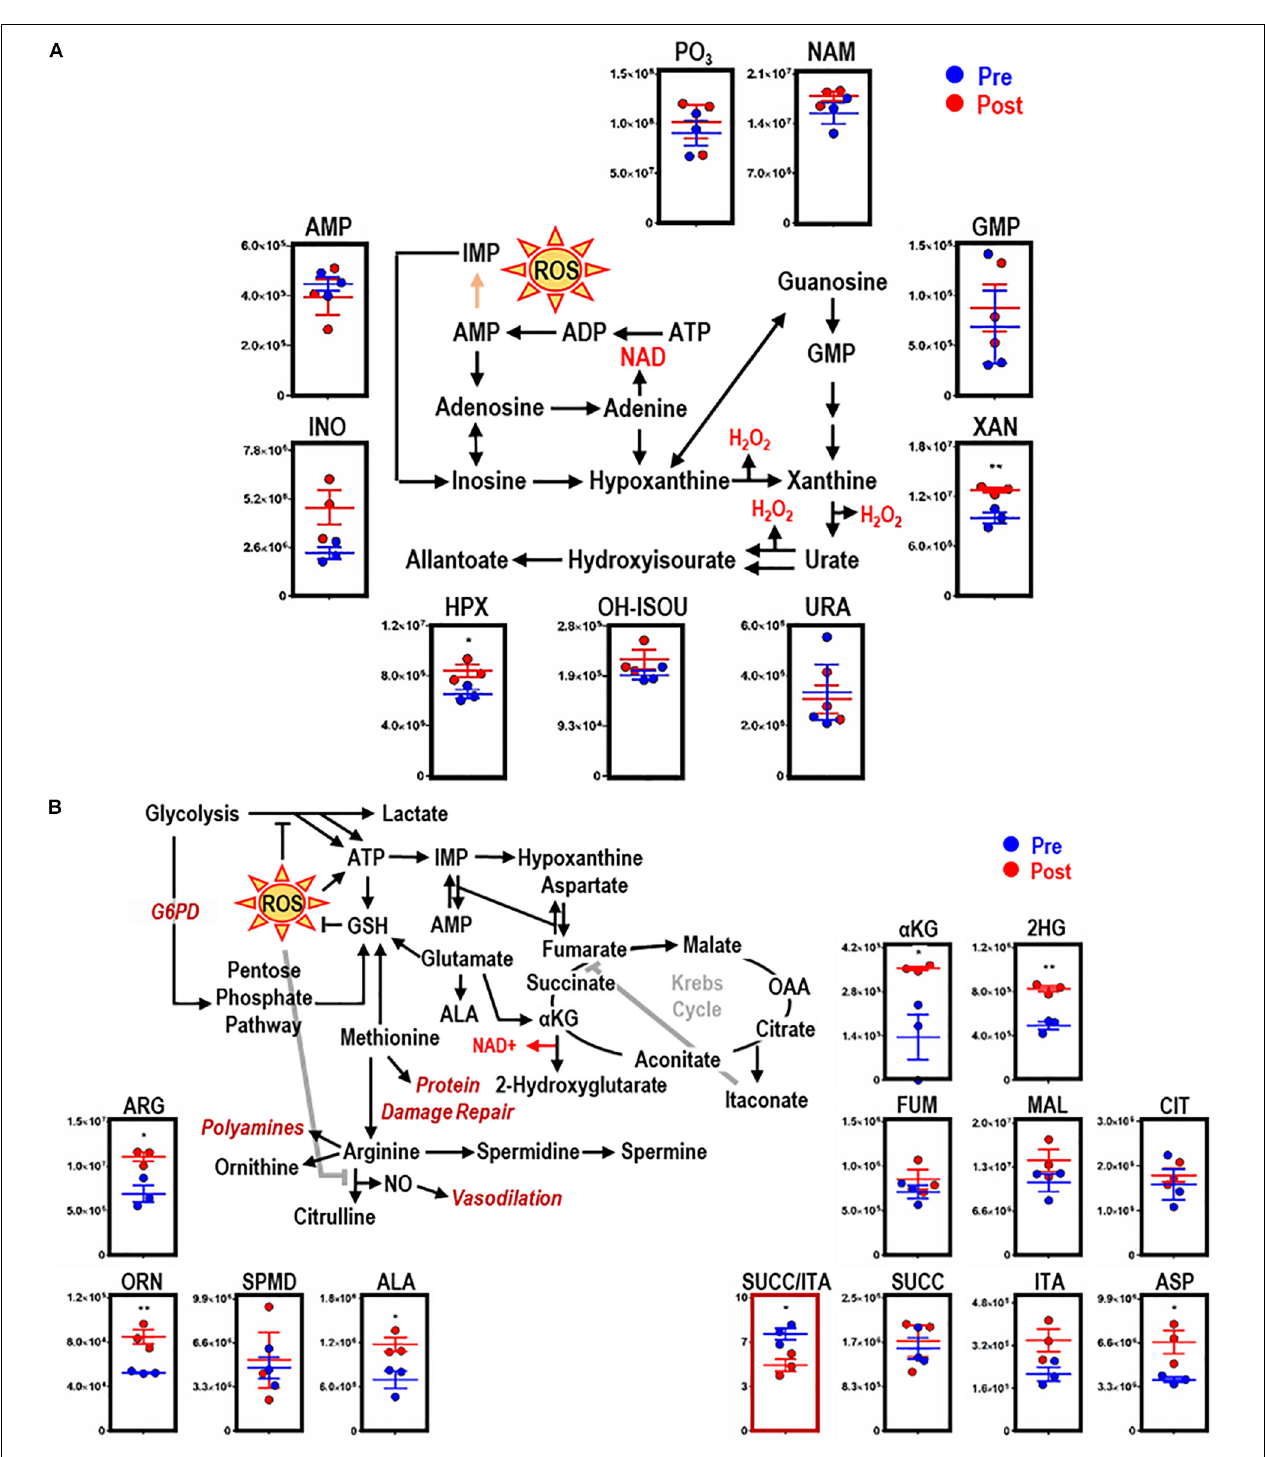
FIGURE 4 | EP remodels purine and arginine metabolism, glutathione homeostasis, and the Krebs cycle in BMDMs. Overview and downstream metabolites of purine metabolism with entry into this pathway beginning with adenosine triphosphate (ATP) (A) . Overview of arginine (ARG) metabolism, GSH homeostasis, and the Krebs cycle (B) . For all plots, the y-axis represents relative intensity (a.u.). * p ≤ 0.05; ** p ≤ 0.01; *** p ≤ 0.001 (unpaired t -test, 2-tailed distribution). PO 3 , phosphate; URA, urate; AMP, adenosine monophosphate; NAM, nicotinamide; HPX, hypoxanthine; INO, inosine; XAN, xanthine; ALA, aminolevulinate; ASP, aspartate; 2HG, 2-hydroxyglutarate; SUCC, succinate; ORN, ornithine; OH-ISOU, hydroxyisourate; SPMD, spermidine; SPM, spermine; ITA, itaconate; FUM, fumarate; CIT, citrate; MAL, malate; α KG, α -ketoglutarate.